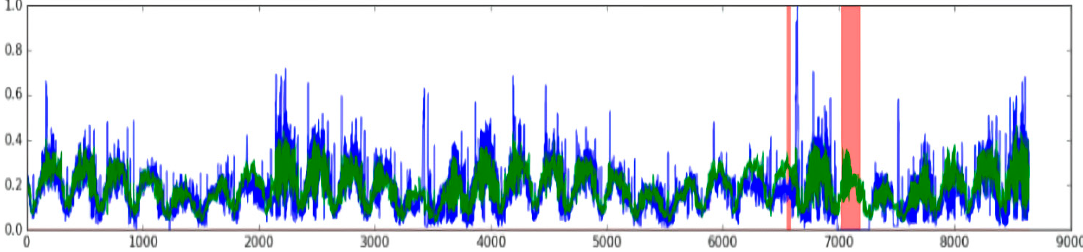
Figure 3. Example of time series data analysis result for abnormal symptom detection using deep neural network (DNN) model.